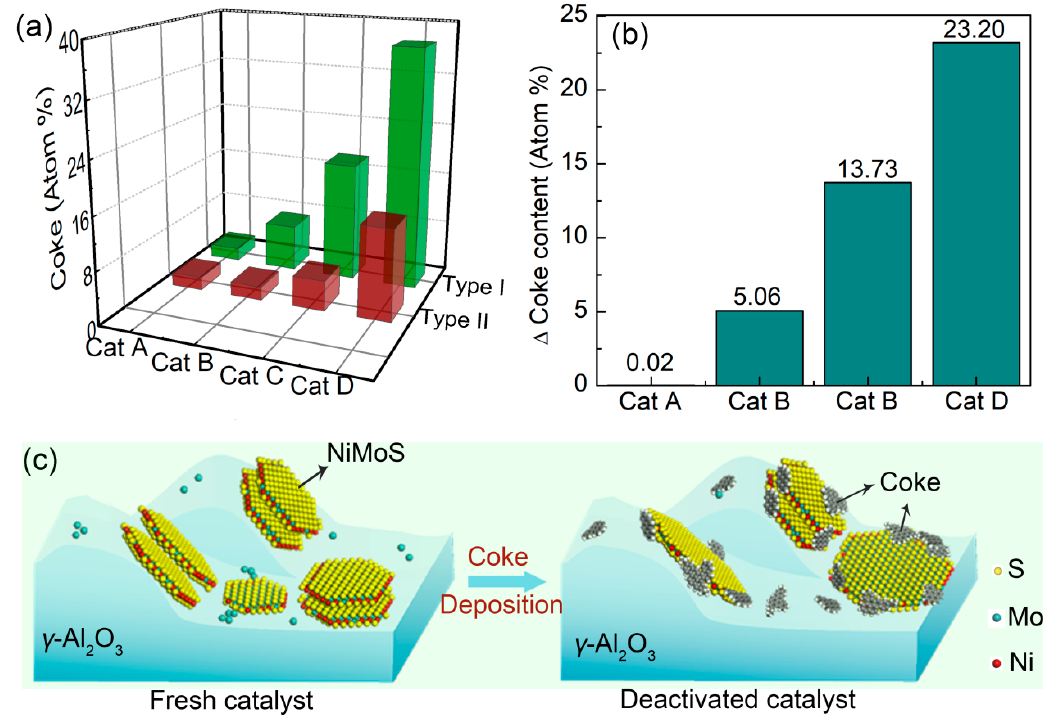
Figure 6. ( a ) Coke amounts on Type I regions and Type II regions for the four catalysts, ( b ) the difference in coke amount between Type I and Type II regions, and ( c ) schematic drawing of coke deposition on NiMo/ γ -Al 2 O 3 catalyst during catalytic reaction.